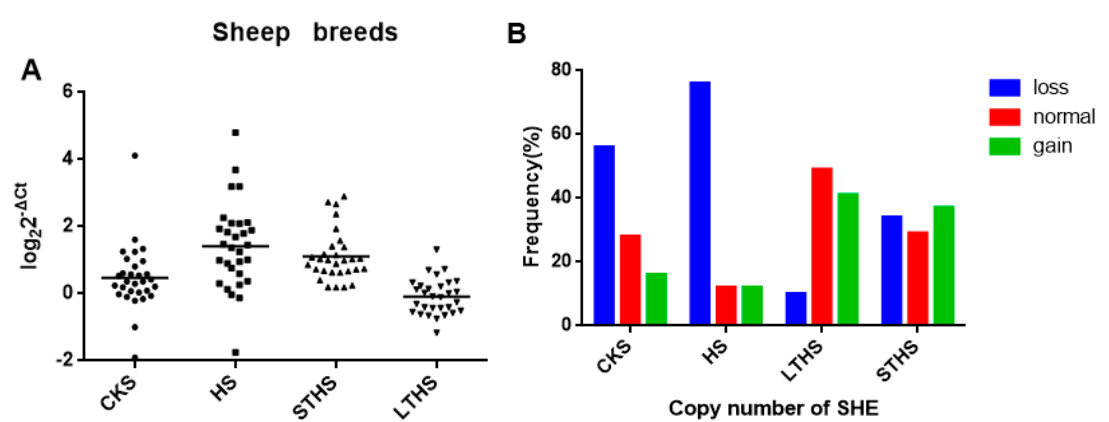
Figure 4. ( A ) The distribution of the SHE gene’s CNV in four sheep breeds. ( B ) The frequency of the copy numbers of the SHE gene’s CNV in the four sheep breeds.